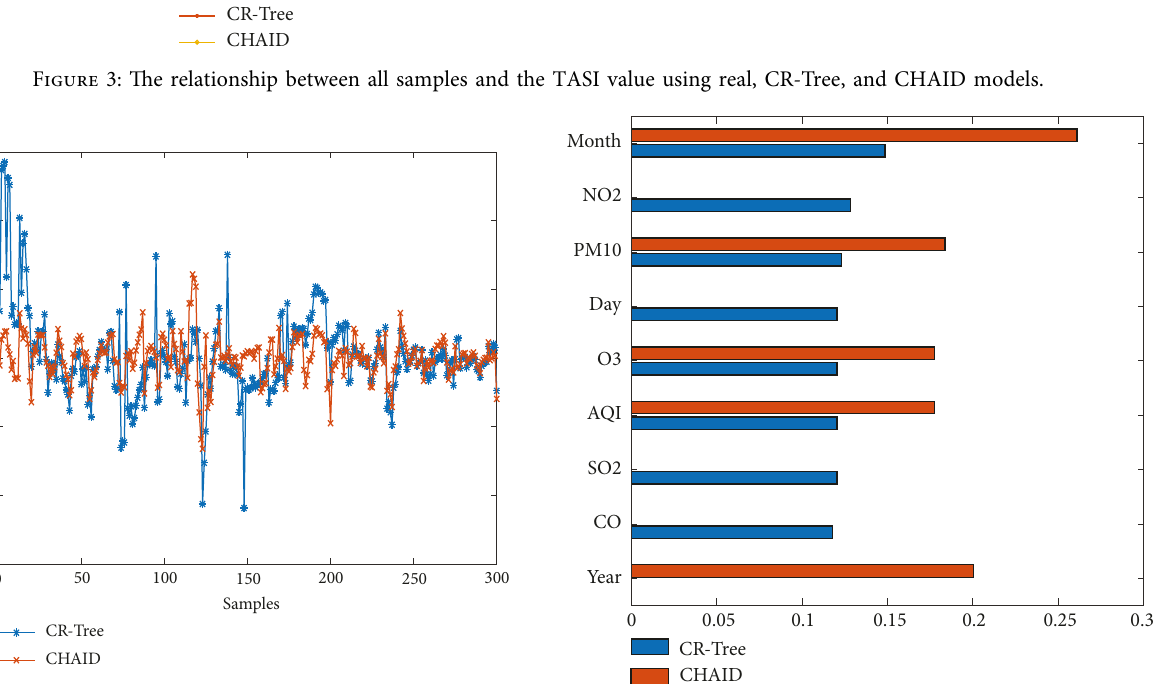
Figure 4: Train error function, testing, and validating samples using CR-Tree and CHAID.